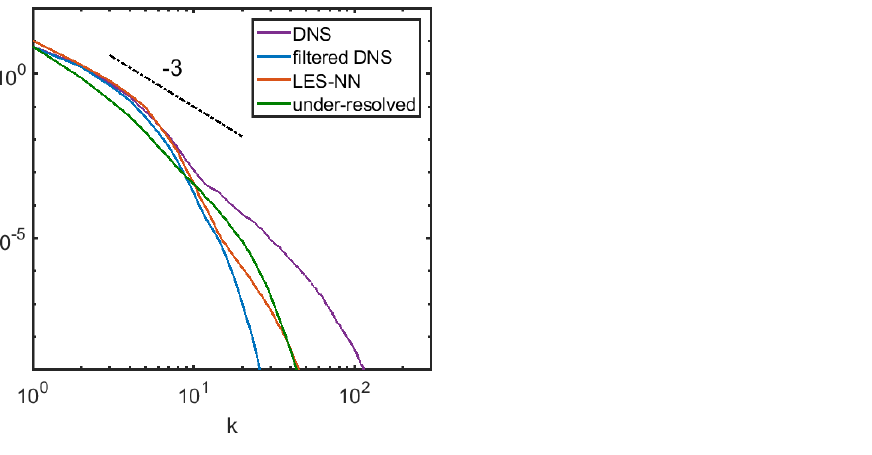
Figure 6. The 1D-energy spectrum of the DNS field, the filtered DNS field, the LES field and the coarse grid solution.